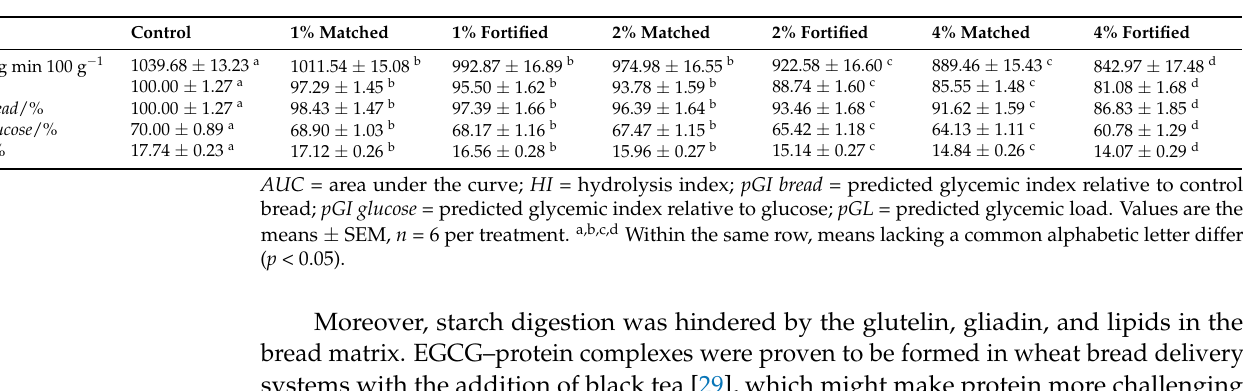
Table 2. The glycemic reduction characteristics in vitro of bread fortified and matched with EGCG.